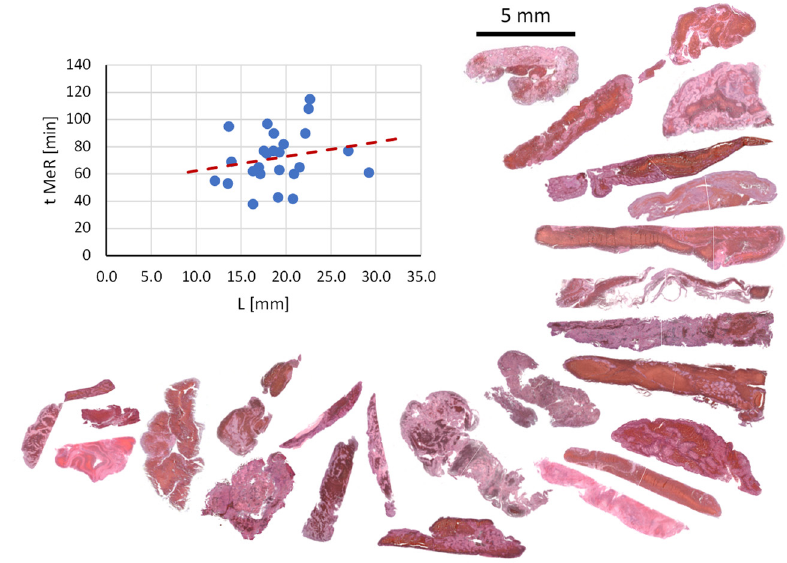
Figure 4. A correlation plot between the mechanical thrombectomy procedure time and the thrombus length. From the plot it can be seen that the procedure time increases with the thrombus length. The figure also shows histological images of all the thrombi in the study ordered by their lengths. All data of the thrombi qualified for the study are presented in Table 1. The data are grouped according to the categories into MRI, CT, histology, interventional procedure and clinical parameters; all together there are 16 parameters on each thrombus. This data then enabled the calculation of correlations between different pairs of parameters. The calcu- lated correlation coefficients are displayed in Table 2 with Pearson correlation coefficients above the diagonal cells and Spearman correlation coefficient below the diagonal cells. The correlation pair of a cell is identified by the parameters corresponding to the intersec- tion of the row and column of the cell. Cells with correlation coefficients considered sig- nificant are highlighted in green (0.5 ≤ | ρ | < 1), the semi significant correlation coefficients are highlighted in yellow (0.3 ≤ | ρ | < 0.5), while those that are considered insignificant are left unmarked (| ρ | < 0.3). Table 1. MRI, CT, histological, interventional procedure and clinical parameters of patients diag- nosed with ischemic stroke due to occlusion in the MCA artery that were qualified for the study. MR Parameters CT Parameters Histol. Procedure Parameters Clinical Parameters